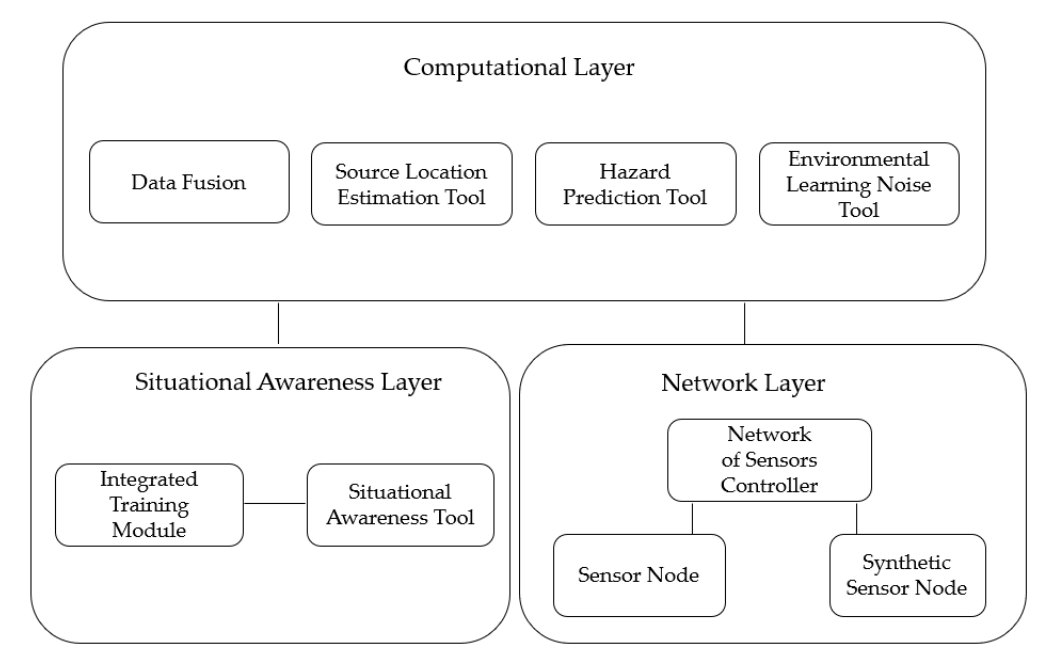
Figure 1. EU-SENSE system architecture [36] .